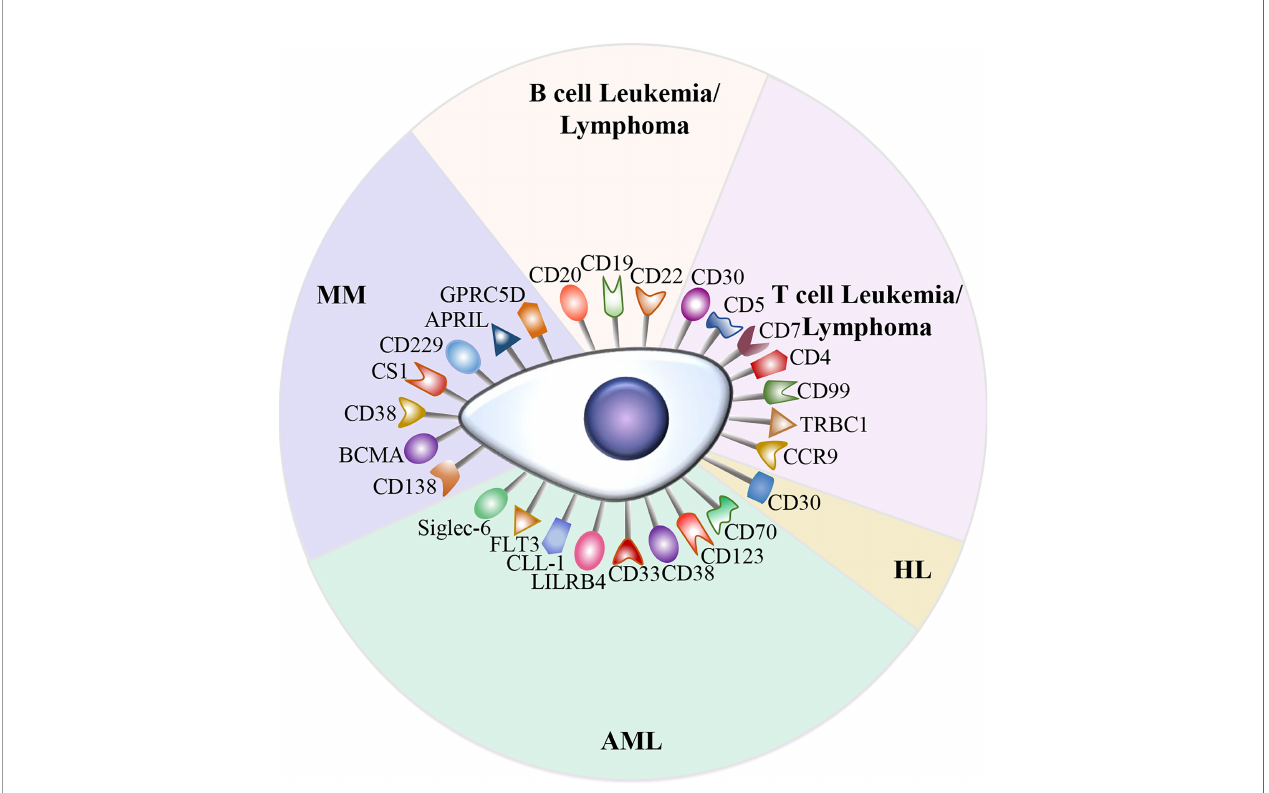
FIGURE 2 | Potential therapeutic targets in hematological malignancies. A variety of attractive targets for CAR-T cell therapy in hematological malignancies, including T and B cell leukemia/lymphoma, HL, AML, and